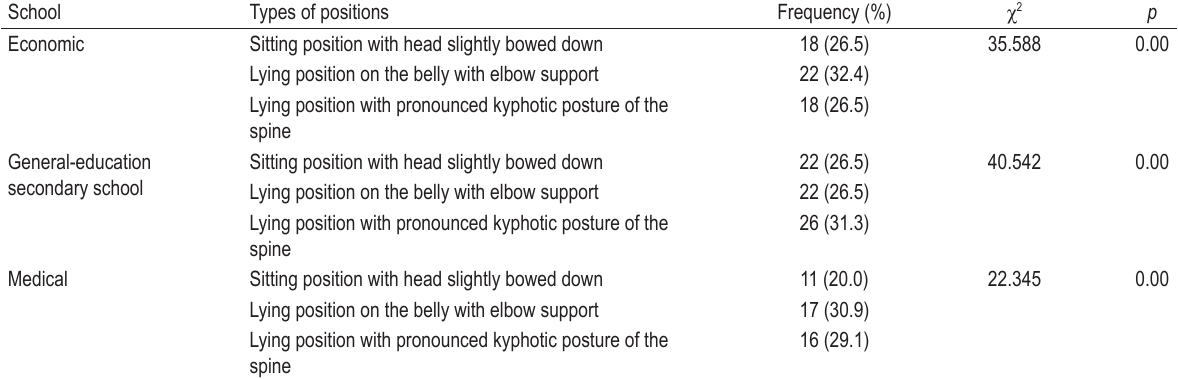
TABLE 5. The most common positions that students take when reading